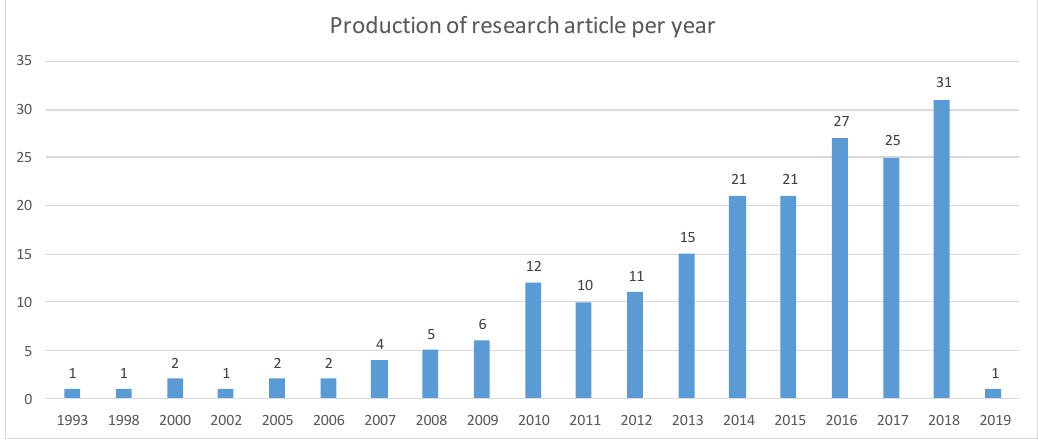
Figure 1. Number of research article per year.